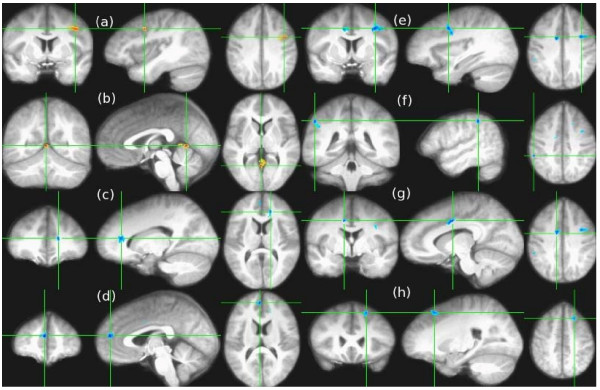
This figure illustrates significant differences in cannabis users relative to non-users in both ADC and FA. Coronal, sagittal and axial views (moving from left to right, respectively) illustrate that the apparent diffusion coefficient (ADC) for adolescent cannabis users (N = 10) was significantly (p < 0.01, cluster size >200 mm3) lower relative to non-cannabis users (N = 10) in left middle frontal gyrus (a): Talairach coordinates -41 [L],3 [A],36 [S], and posterior to the right posterior cingulate (b): 2 [R],-54 [P],4 [S] (shown in orange superimposed on the average registered MPRAGE images from all 20 subjects), and that the fractional anisotropy (FA) was significantly higher (shown in blue) in cannabis users in the left anterior cingulate (c): -16 [L],32 [A],11 [S], right medial frontal gyrus (d): 3 [R],46 [A],18 [S], left precentral gyrus (e): -32 [L],1 [A],33 [S], right inferior parietal (f): 50 [R],-38 [P],39 [S], right cingulate gyrus (g): 10 [R],-3 [P],35 [S], and left superior frontal gyrus (h): -20 [L],21 [A],45 [S].